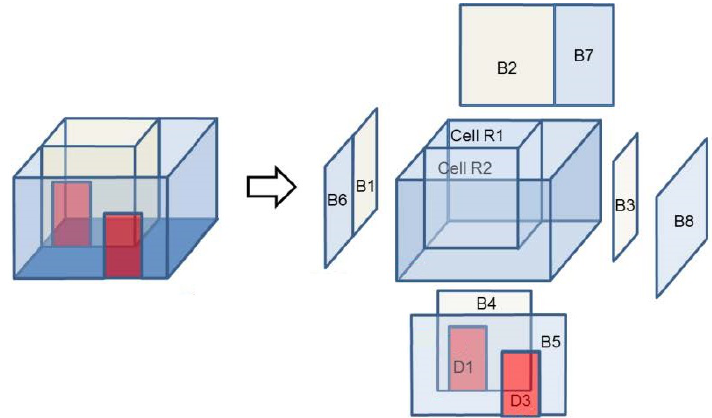
Figure 8. Example of the indoor 3D space modelling in IndoorGML [129].